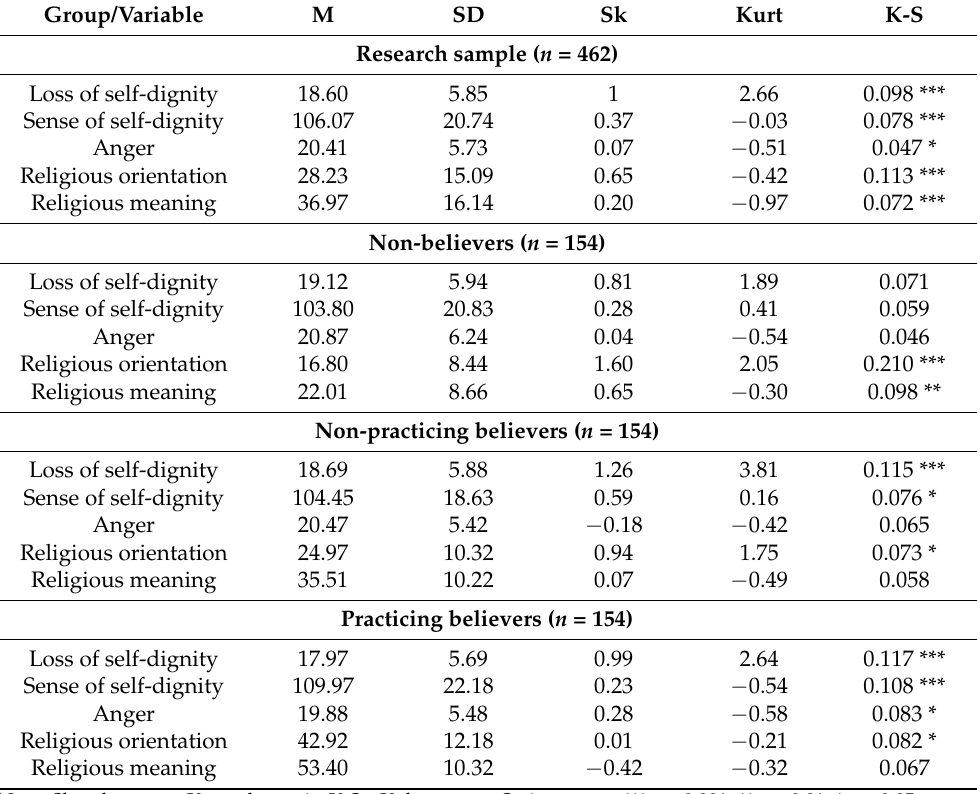
Table 2. Basic descriptive statistics and the results of the Kolmogorov–Smirnov